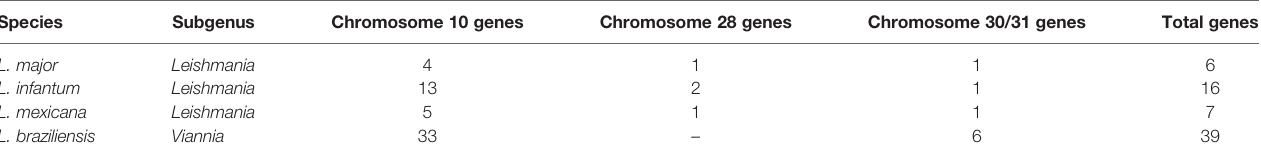
TABLE 2 | Gp63 gene repertoire among the main medical interest species of Leishmania distributed by subgenus and chromosome.